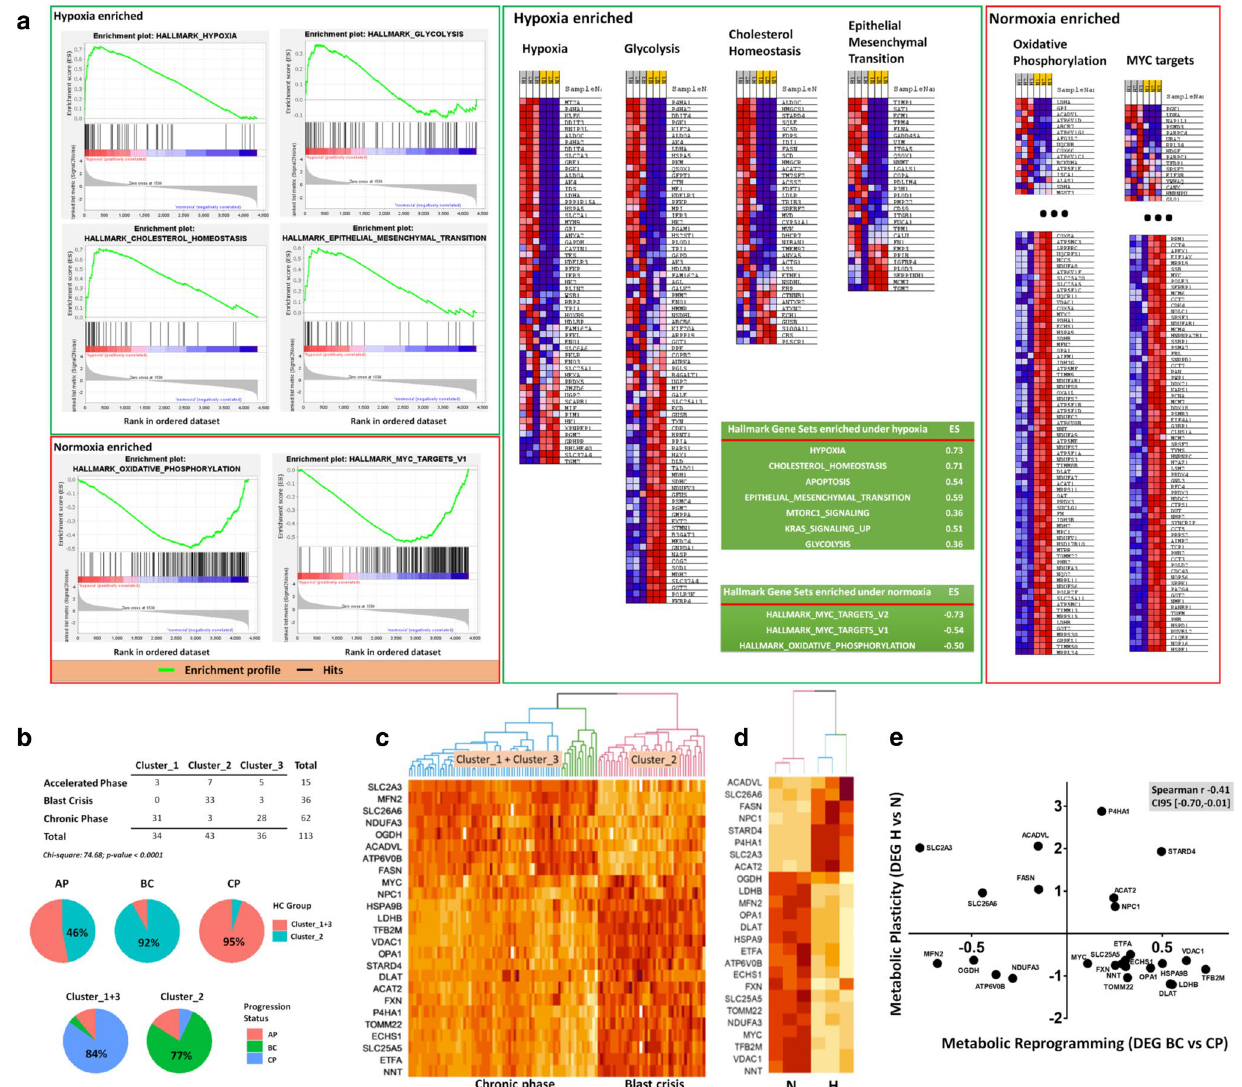
Fig. 6 A 25-gene metabolic plasticity signature derived from BC-K562 cells under hypoxia. a Gene set enrichment analysis of BC-K562 cells exposed to 1% hypoxia for 72 h. The RNA expression values of 4362 genes of three replicates under hypoxia and three replicates under nor- moxia were compared over 50 functional Hallmark gene lists (MSigDB). Enrichment, indicating RNA over or under-expression, is represented by profile line graphs, where the black bar represents a single gene from the list of 4362 genes, which matched a gene of the Hallmark list (hit), and the line represents over-expression (left peak) or under-expression (right peak) in a comparison hypoxia vs normoxia, or normoxia vs hypoxia (hypoxia-enriched, and normoxia-enriched respectively). Clustered black bars on the left indicate over-expression, and clustered black bars on the right indicate under-expression. The enrichment score (ES) provides a magnitude of over-expression (positive value) or under-expression (negative value) of genes of the Hallmark functions (see Materials and Methods section). The detailed genes (hits) found in each Hallmark gene list are shown as heatmaps on the right (they correspond to the black bars in the enrichment profile graphs shown on the left). Red squares are genes over-expressed and blue squares are gene under-expressed in hypoxia. Each column of the heatmaps represents an RNAseq sample. Since the middle part shows genes expressed similarly in hypoxia and normoxia we omitted the middle part (indicated by three large dots). b Contingency table exploring association between clinical categories CP, AP and BC and unsupervised clas- sification of 113 CML patients according to their RNA expression profile. The patients were classified into Cluster_1, Cluster_2 and Cluster_3, considering only RNA expression values of a 25-gene metabolic plasticity signature, selected among those genes that we found differen- tially expressed in BC-K562 cells under hypoxia. Pie charts illustrates how the three clinical categories fit in two main “metabolic” clusters (Cluster_1 + 3 and Cluster_2) with CP and BC cases clearly separated, and AP cases fitting half in each cluster. c Heatmap showing expres- sion profile with unsupervised classification of 113 CML patients using the 25-gene metabolic plasticity signature obtained from BC-K562 cells under hypoxia. The 25 genes are listed on the left of the heatmap. BC patients are clearly associated to the profile of cluster_2 while CP patients are associated to profiles of Cluster_1 + 3. d Heatmap presenting unsupervised classification of six BC-K562 transcriptomes and showing that the 25-gene MP-signature also discriminates between BC-K562 cells under hypoxia and normoxia. e Correlation plot showing that the gene expression profile of these 25 genes is different and inversely correlated when comparing BC patients to CP patients (meta- bolic reprogramming) than when comparing BC-K562 cells under hypoxia vs normoxia (metabolic